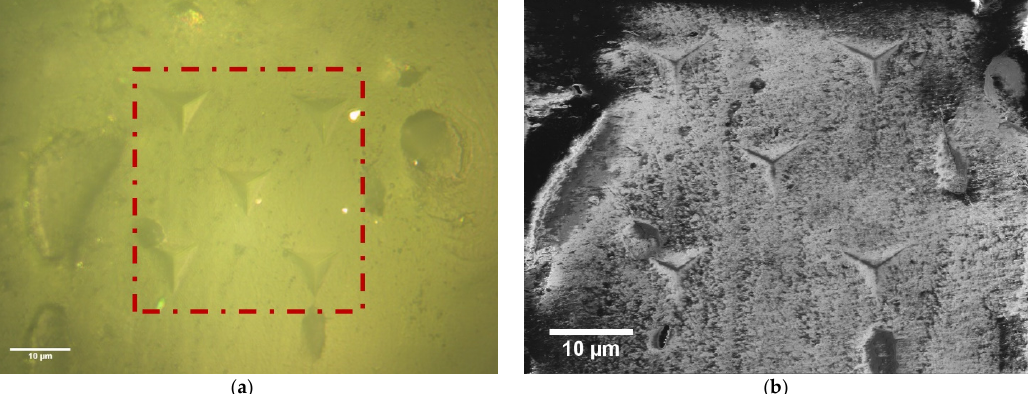
Figure 3. Typical imprints left by the nanoindenter for bone tissue. ( a ) Optical microscopy image of 5 isolated indentations at a depth of 2000 nm. ( b ) SEM image of five isolated indentations at a depth of 2000 nm. The distance between each indentation was 25 µm for both images.